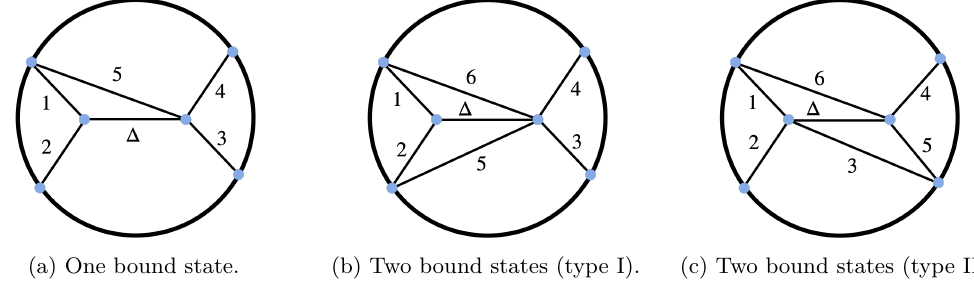
Figure 1 . Three basic of Witten diagrams with one or two bound states and only one bulk-to-bulk propagator. Here the external bound states are the boundary points from which two lines